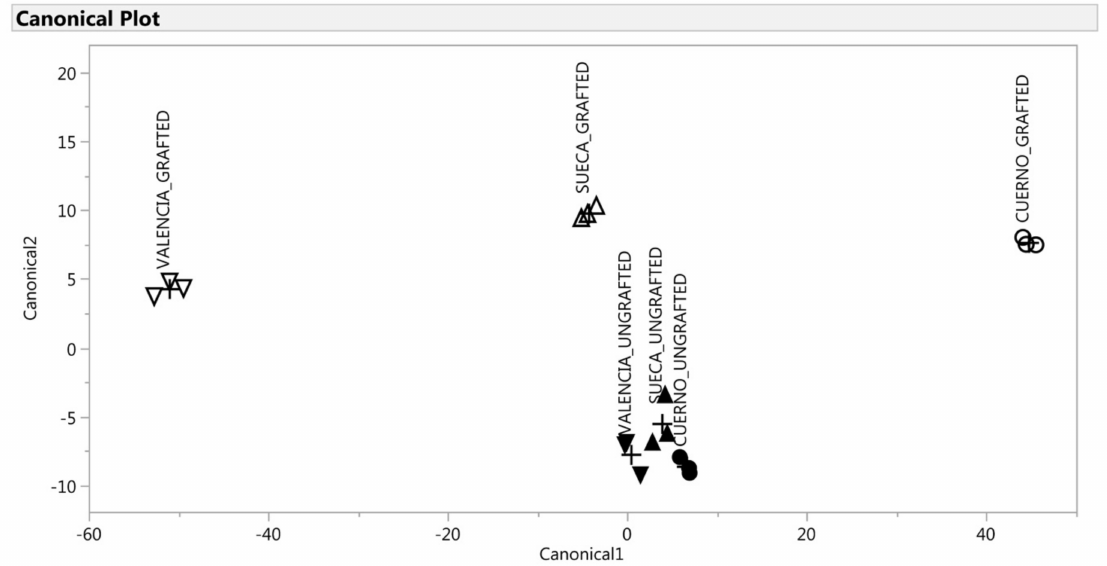
Figure 5. Discrimination of the VOCs of the green fruit based on the canonical discriminant analysis.